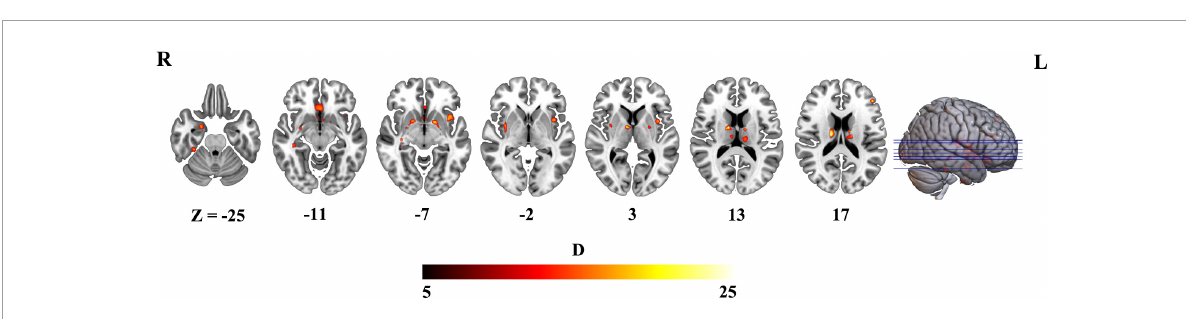
FIGURE3 Brain regions exhibiting higher the coefficient of variation (CV) in schizophrenia ( p < 0.05, FDR